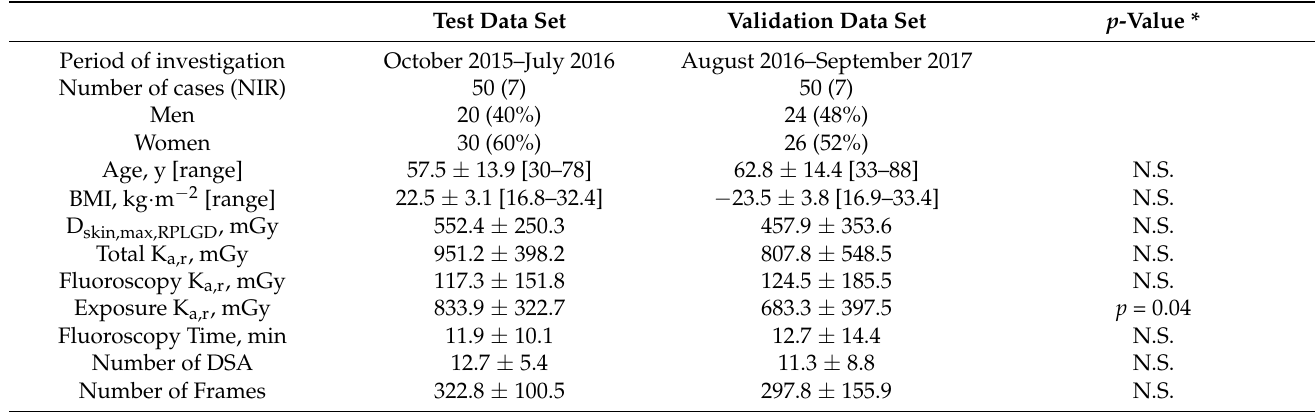
Table 2. Data set